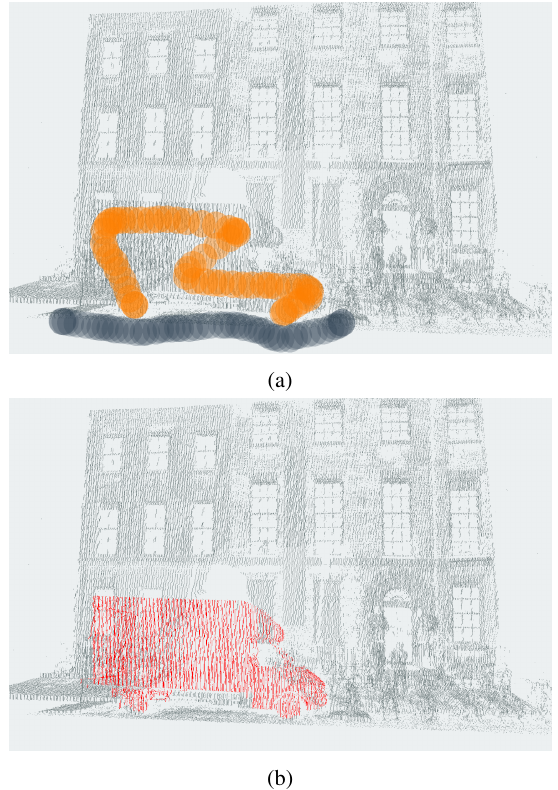
Figure 6: The two strokes shown in (a) are drawn by users. The orange one specifies the target object, i.e., a van in the point cloud, and the gray one specifies the background. The strokes are sparse and don’t necessarily cover a large part. Using graph cuts, the selection of the orange stroke can propagate over the whole object and hence the van is segmented out from the point cloud as displayed in